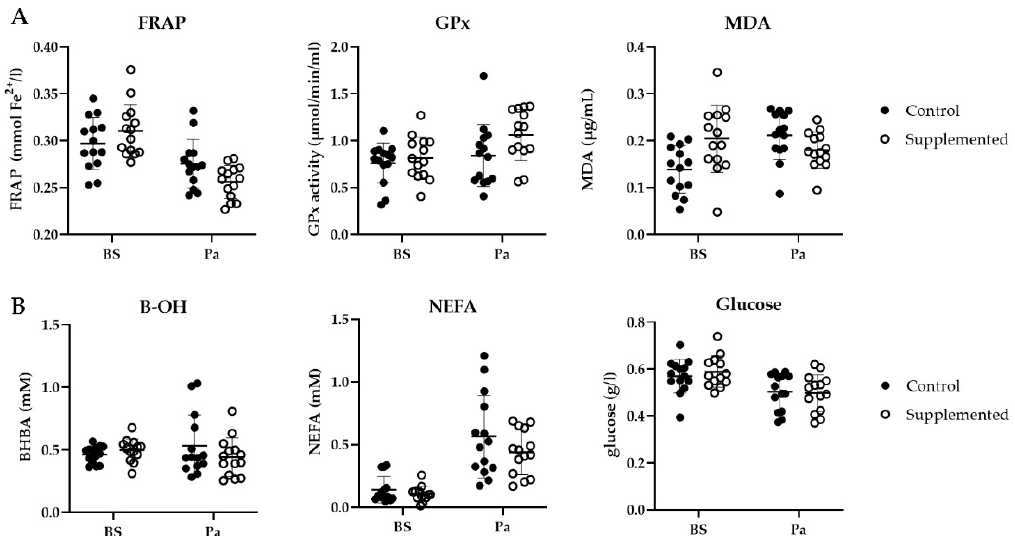
Figure 8. ( A ) Ferric reducing ability of plasma (FRAP, mmol Fe 2+ /L), GPx activity ( µ mol/min/mL) and plasmatic MDA concentration ( µ g/mg protein); ( B ) BHBA (mM), NEFA (mM) and glucose (g/L) in the control (full circle) or the SC (open circle) ewes before supplementation (BS) and around parturition (Pa) ( n = 14 per group).